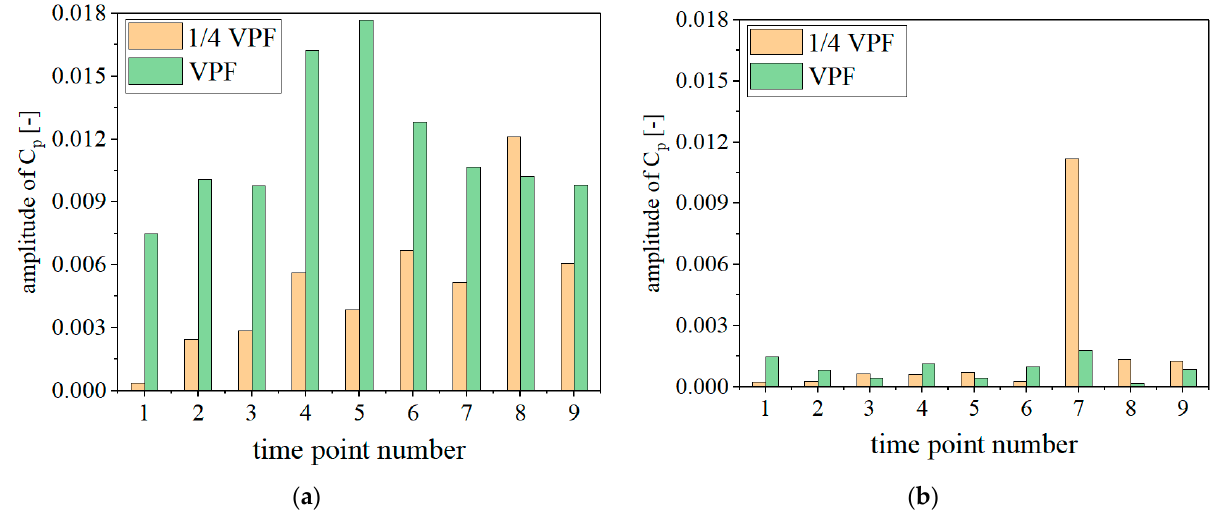
Figure 24. The pressure fluctuation amplitude at 1/4 VPF and VPF. ( a ) P1; ( b ) P2.